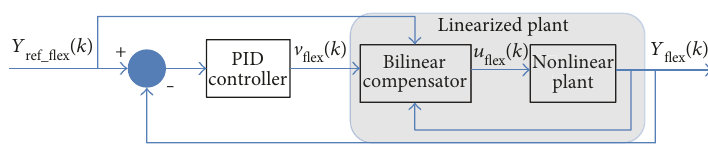
Figure 14: Control scheme for SMA-based wearable elbow exoskeleton (adapted from [33]).